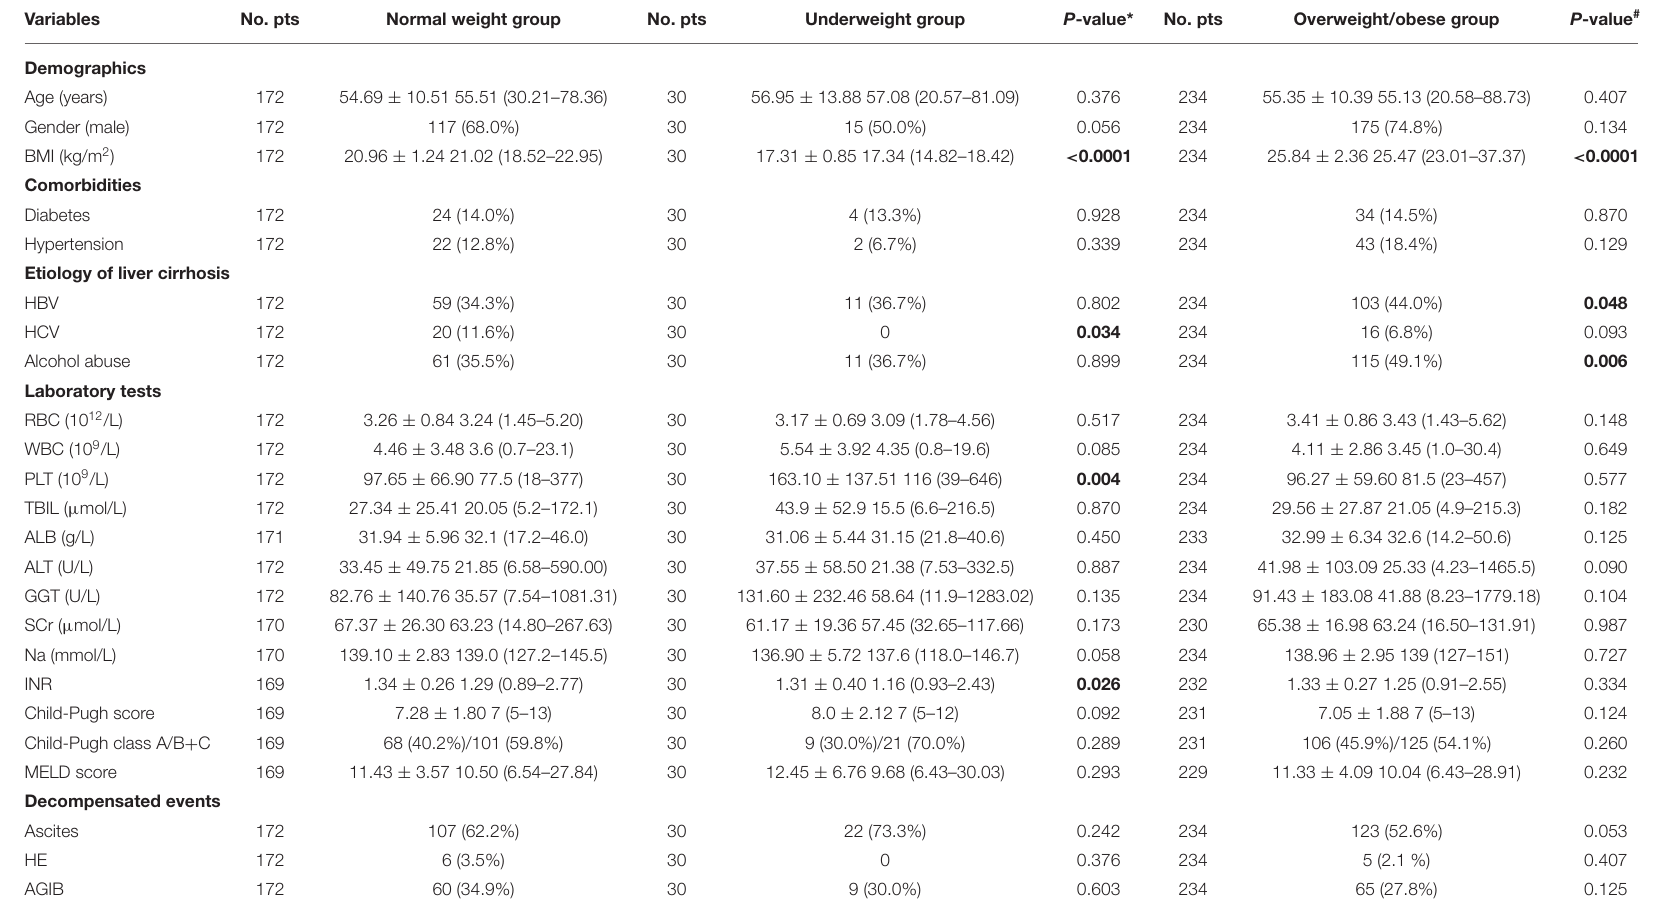
TABLE 1 | Baseline characteristics of patients with cirrhosis in the first part.